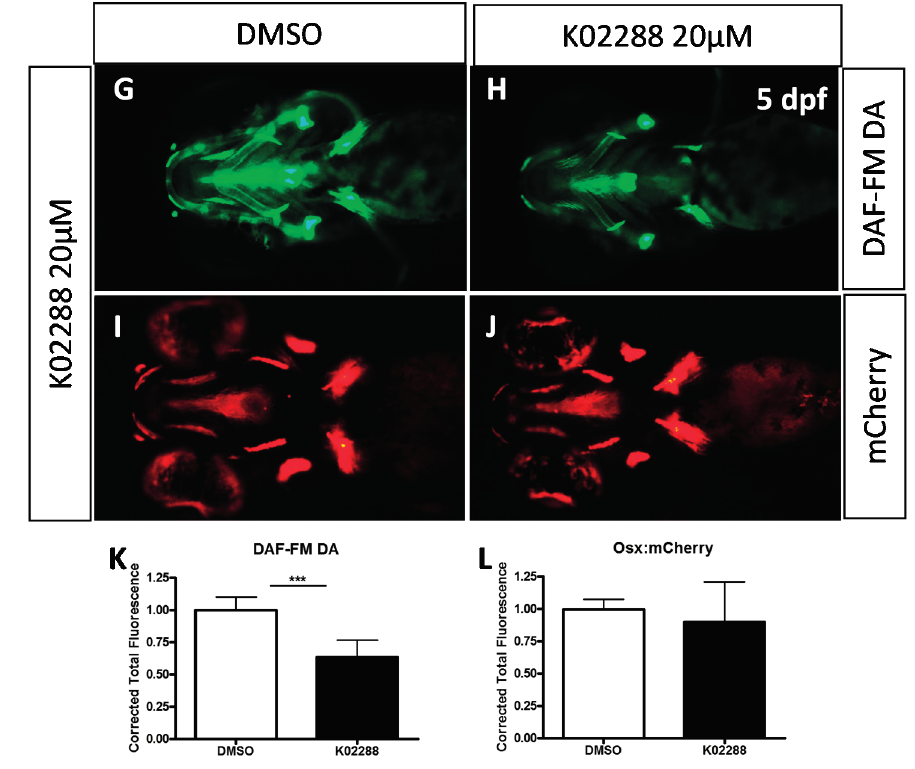
Figure 4. Effects of dorsomorphin ( A – F ) and K02288 ( G – L ) on NO production and osterix expression. (A,B,G,H) Nitric oxide labelling by DAF-FM DA of 5 dpf Tg (osx:mcherry) larvae previously treated during 24 h with 100 µM dorsomorphin (B) or 20 µM K02288 (H) at 2 dpf. (C,D,I,J) mCherry red fluorescence of 5 dpf Tg (osx:mcherry) larvae previously treated during 24 h with 100 µM dorsomorphin (D) or 20 µM K02288 (H) at 2 dpf.